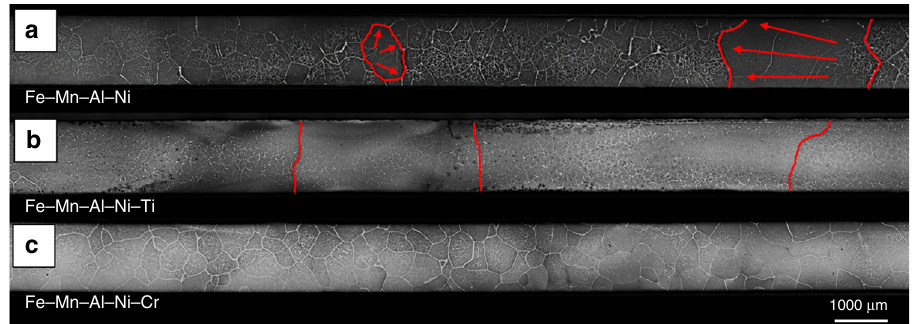
Fig. 5 Grain growth behavior after one cyclic heat treatment. Optical micrographs of Fe – Mn – Al – Ni ( a ), Fe – Mn – Al – Ni – Ti ( b ), and Fe – Mn – Al – Ni – Cr ( c ) after the heat treatment detailed in Supplementary Fig. 1c. Grain boundaries of abnormal grown grains are highlighted by the red lines. Red arrows indicate the growth direction of the grains in Fe – Mn – Al – Ni